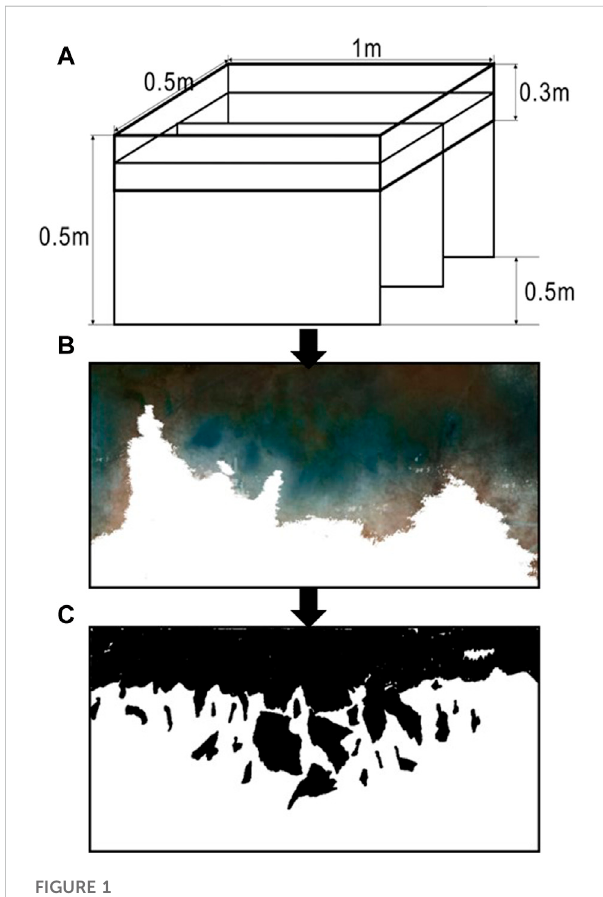
FIGURE 1 Scheme of the dye-tracing experiment and image analysis processes. (A) Vertical section diagram. (B) Cutting and noise reduction in Photoshop. (C) Extraction of the dyed regions.